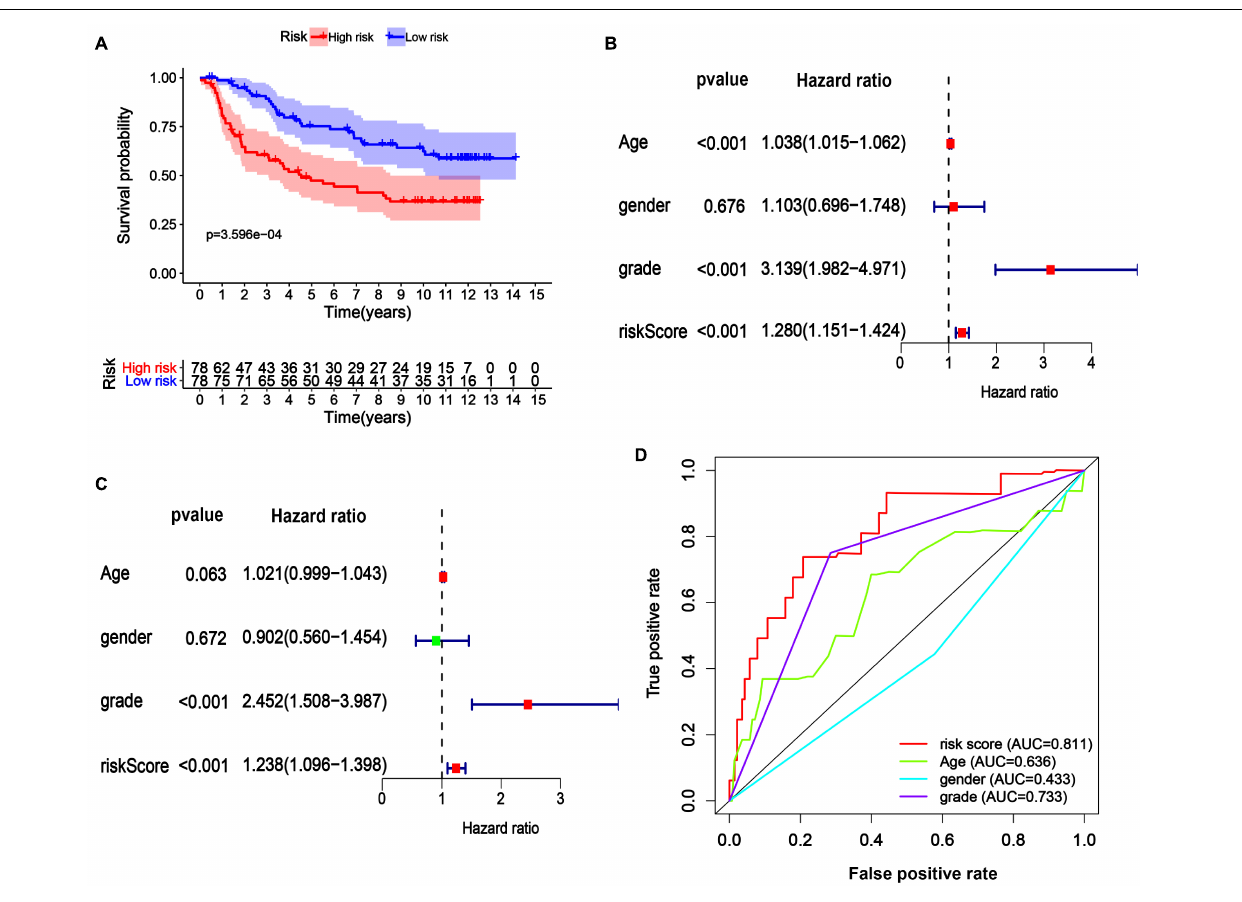
FIGURE 6 | Verification of 29-ERGs signature for the prognosis of a CGGA-LGG cohort. The Kaplan-Meier analysis (A) , Univariate Cox regression analysis (B) , and Multivariate Cox regression analysis (C) , and Muti-index of ROC curve (D) for the mRNA-array_301